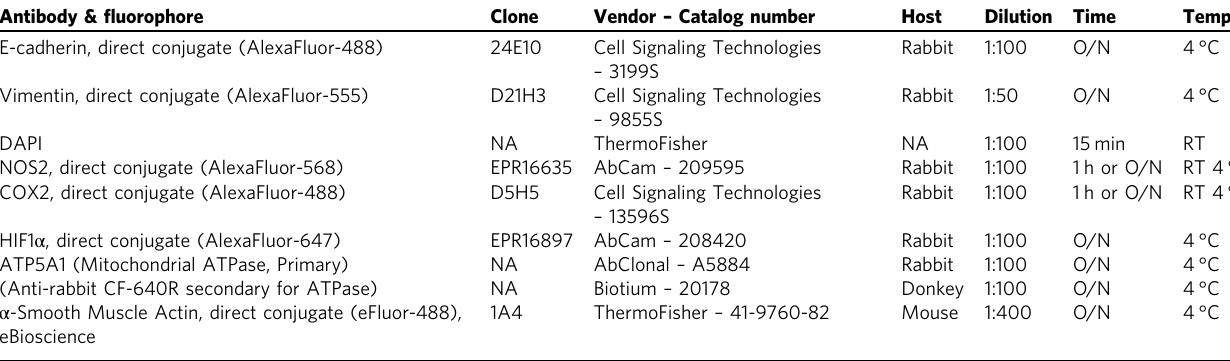
Table 2 Antibodies and fl